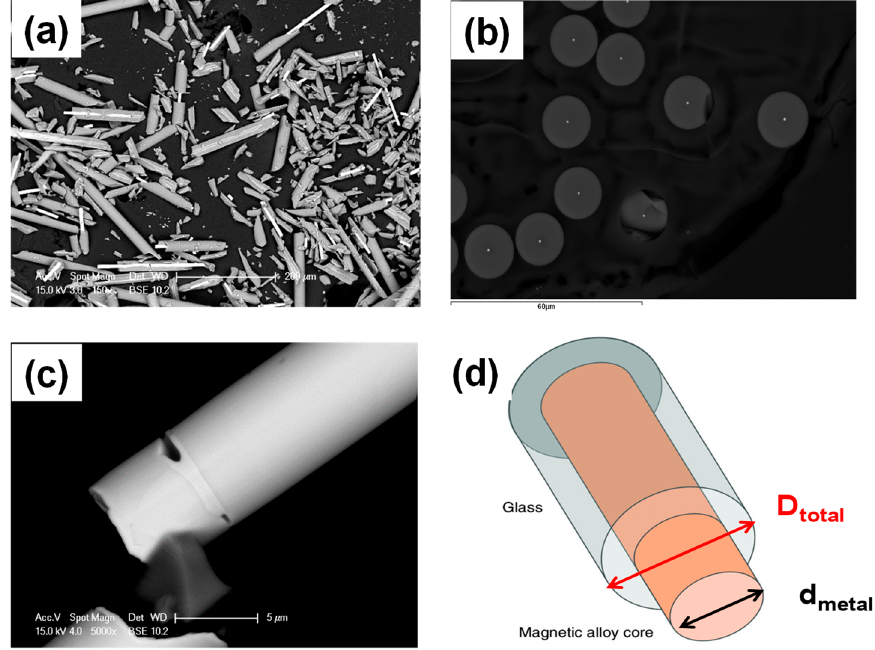
Figure 1. SEM image of Co 2 MnSi glass-coated microwire ( a ) and its cross section ( b ). ( c ) High magnification of a single glass coated microwire and ( d ) indicates the formation of Co 2 MnSi glass-coated microwires, sketch.